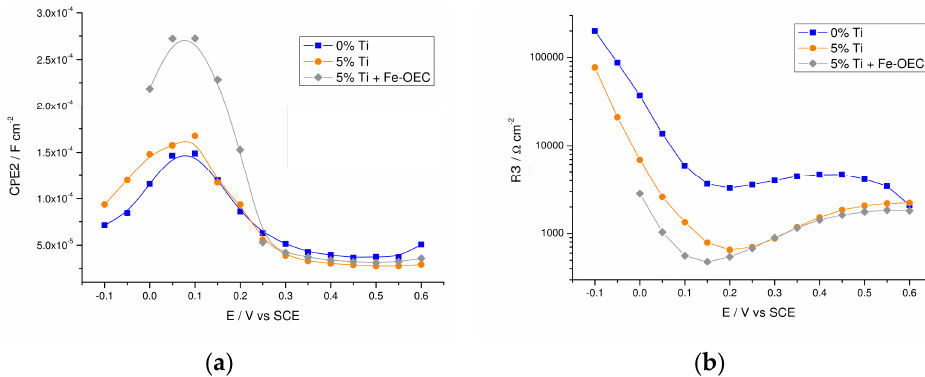
Figure 10. Trapped photohole capacitance and charge transfer resistance extracted from EIS measurements under illumination. ( a ) CPE2 and ( b ) R3 plot of un-modified and 5% Ti-modified hematite electrodes before and after functionalization with Fe-OEC recorded under AM 1.5G illumination in NaOH (0.1 M, pH 13.3).